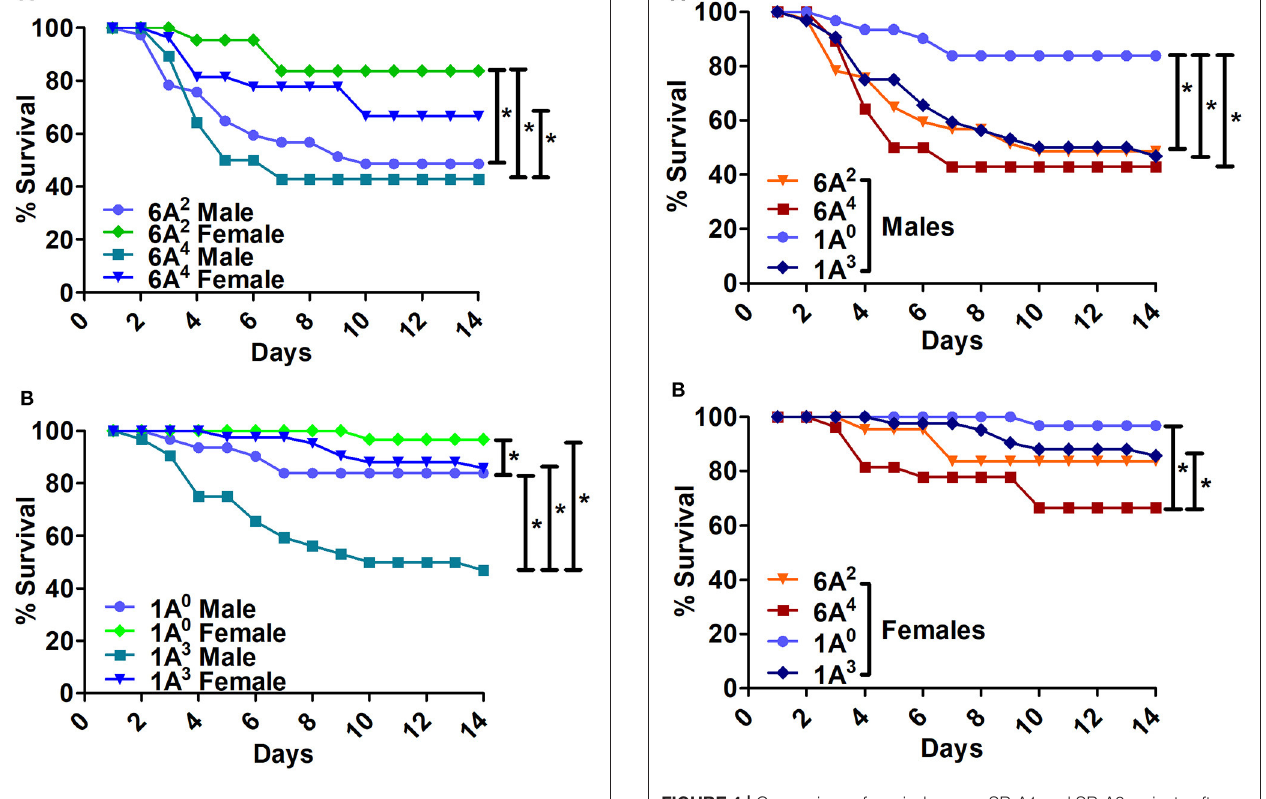
( Figure 7A ). No significant difference was observed (a) between vehicle and SP-A1 or SP-A2 treatment prior to infection ( Figure 7B ), (b) between vehicle and SP-A1 or SP-A2 treatment at the time of infection ( Figure 7C ), or (c) between vehicle and SP-A1 or SP-A2 treatment prior to infection and at the time of infection ( Figure 7D ).